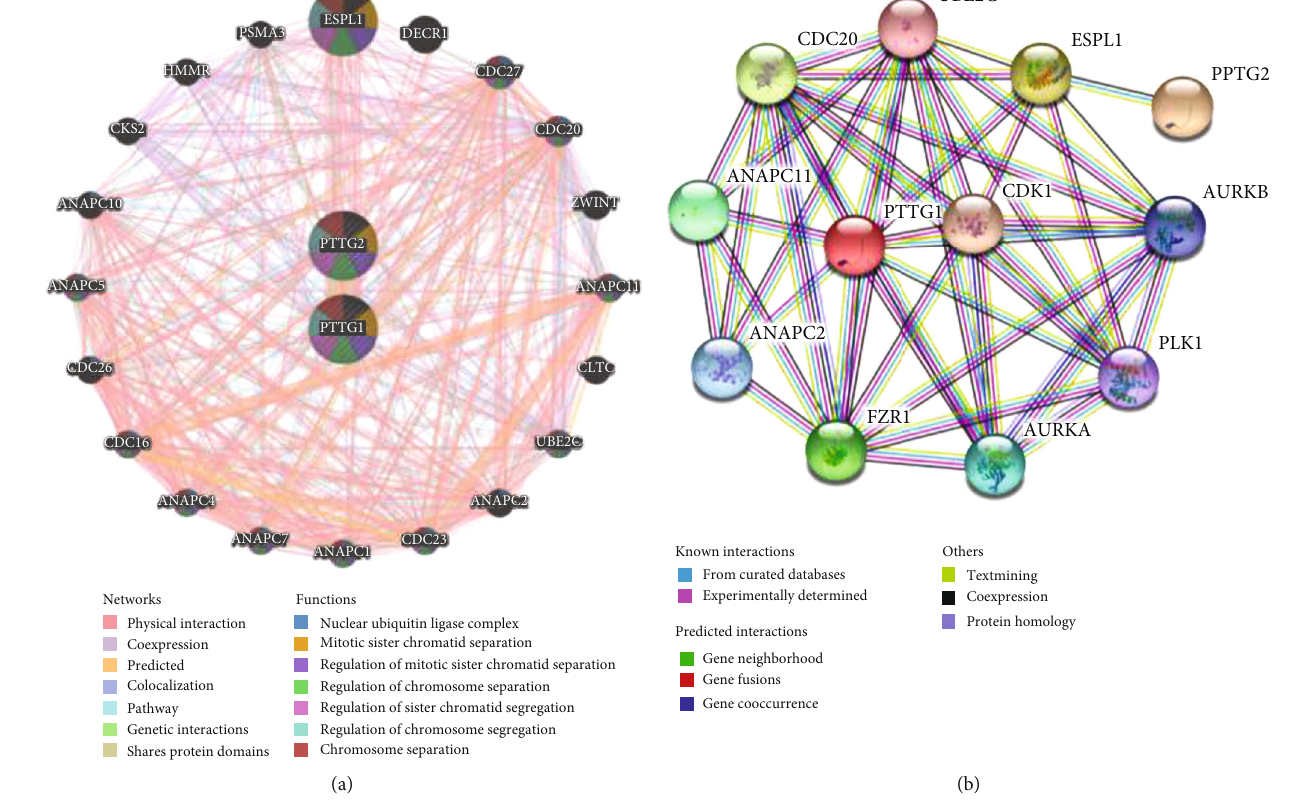
Figure 7: Family member interactions within the PTTG family tree. (a) Gene-gene interaction network of individual PTTGs (GeneMANIA). (b) The PTTG protein-protein interaction